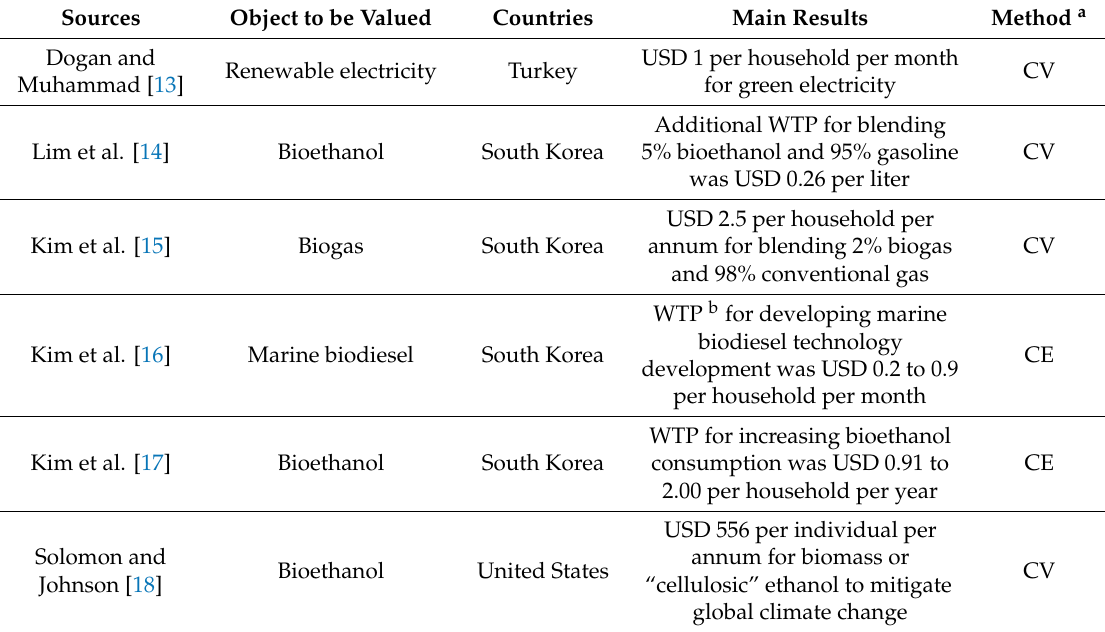
Table 1. Summary of the main findings from former studies concerning renewable